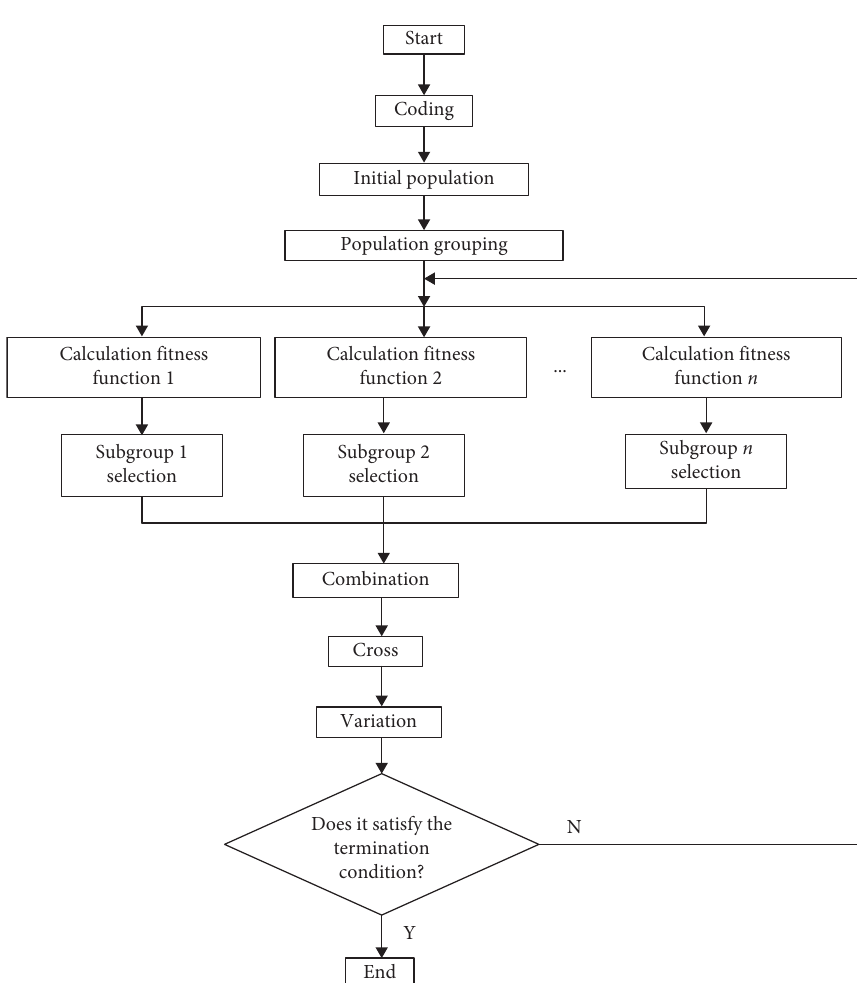
Figure 9: Flowchart of parallel selection genetic algorithm after deconstruction and reconstruction.